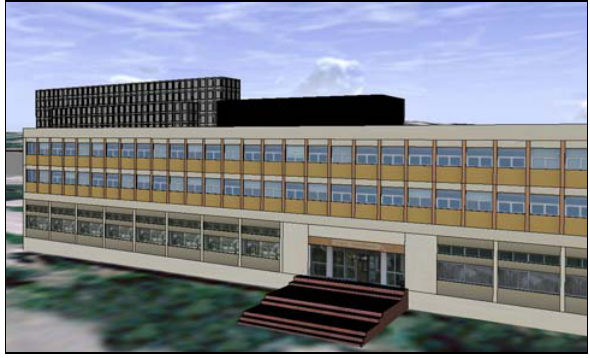
Figure 5. Perspective view of Lampadarios